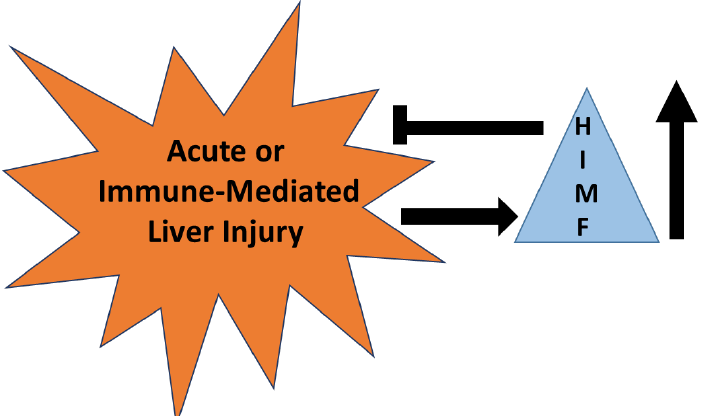
Figure 7. The role of HIMF in acute or immune-mediated liver injury. HIMF is upregulated ( ↑ ) in acute or immune-mediated liver injury. Once up-regulated, HIMF may have a role in reducing the severity of injury that occurs.